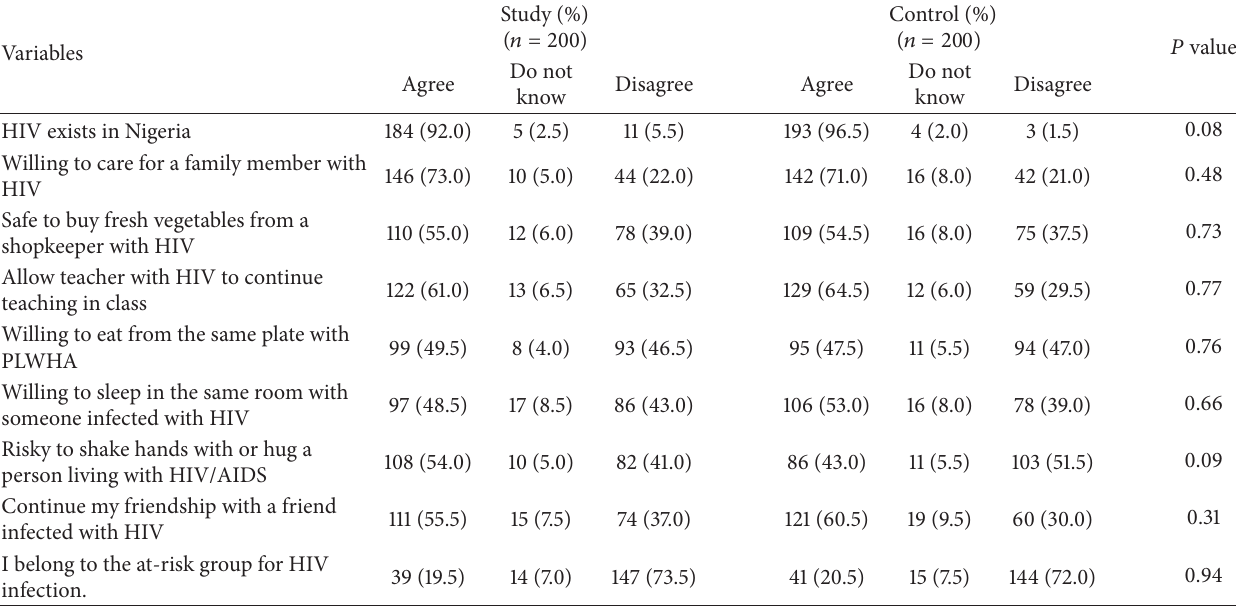
Table 3: Attitude of respondents towards HIV/AIDS at the preintervention